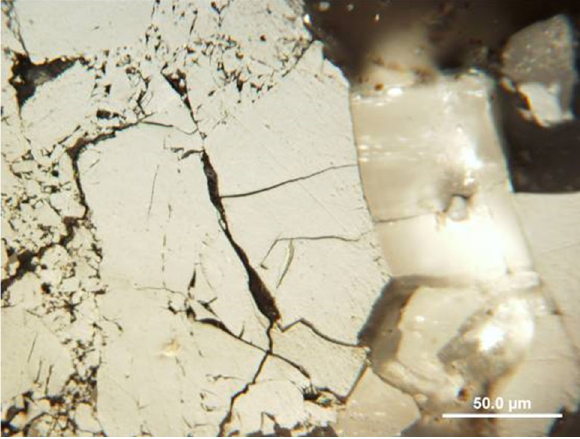
Fig. 14 Low altered collotelinite and vitrodetrinite with microbreccia ( R r =